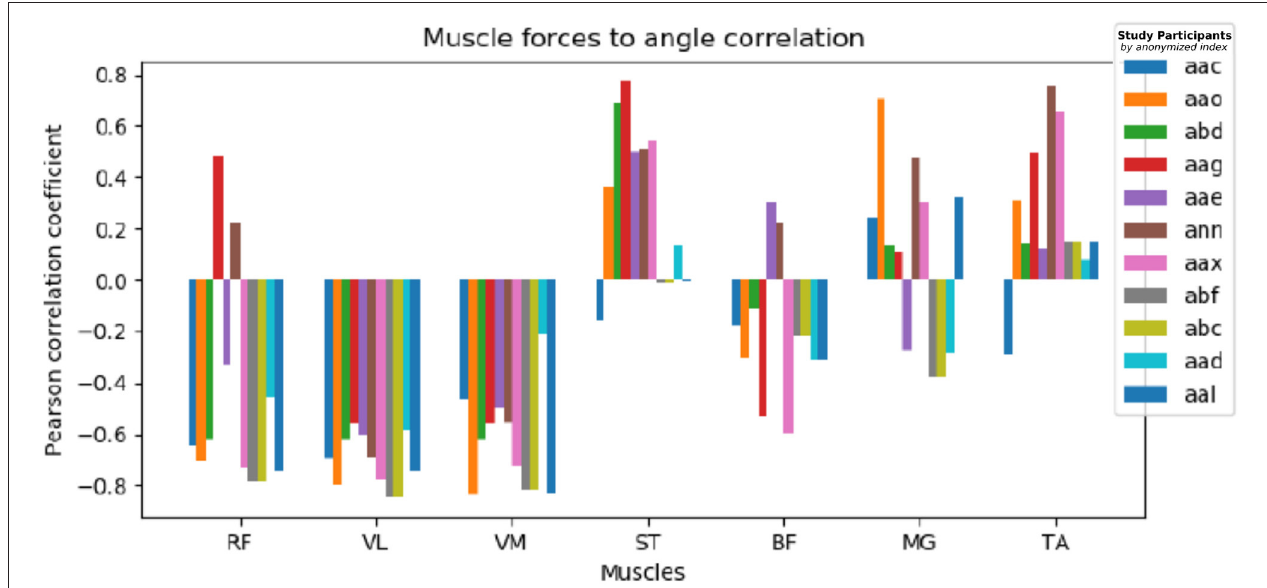
FIGURE 7 | Muscle to knee angle Pearson correlations for multiple patients: Different colors refer to data of different study participants, the Pearson correlation is shown clustered by examined muscle groups. We observe a strong negative muscle activation correlation with the given angle for RF, VL, and VM, contrary ST and TA show a weak positive correlation and no definite correlation can be found common for all participants for BF and MG.